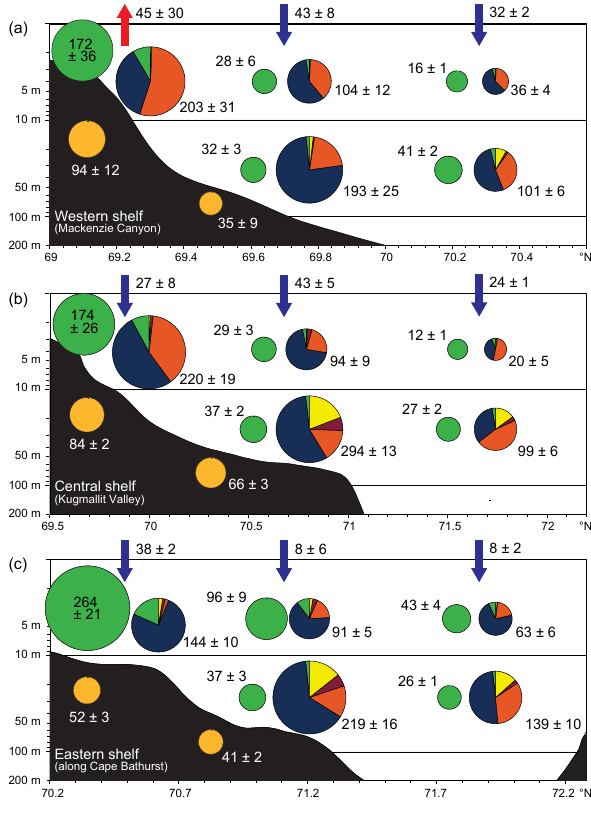
Figure 9. Cross-shelf average estimates (mean ± 0.95 confidence interval) of gross primary production (green circles), total pelagic heterotroph respiration (pie charts), benthic respiration (orange cir- cles in the sediment), and sea-to-air CO 2 fluxes (red and dark blue arrows; same as in Fig. 4). Every pie chart represents the com- bined respiration of phytoplankton (green), bacteria (dark blue), protozooplankton (dark orange), small metazooplankton and nau- plii (dark red), and large metazooplankton (yellow). All units are inmgCm − 2 d − 1 . The western, central and eastern regions corre- spond to the areas delimited by 136–141 ◦ W, 131–136 ◦ W and 126– 131 ◦ W, respectively (Fig. 1). For a detailed description on how each variable has been estimated, please see Sects. 2.5 and